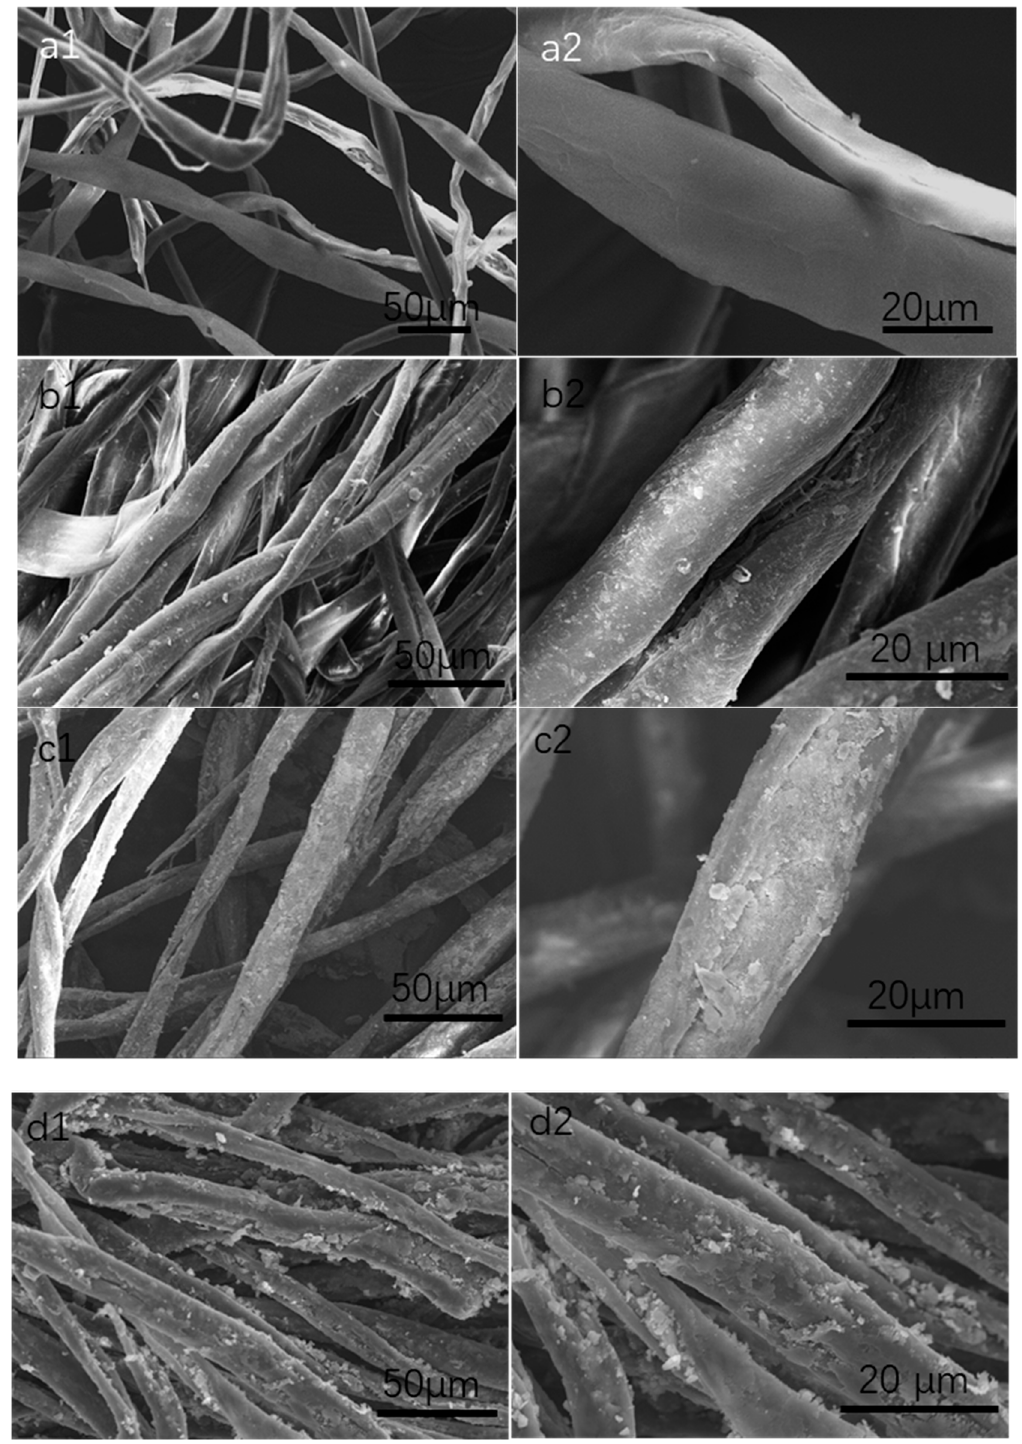
Figure 1. SEM images of raw cotton fabrics ( a1 , a2 ), cotton fabrics modified with different amount of ferric chloride and ferrous chloride ( b1 , b2 ) 0.54 g/0.19 g; ( c1 , c2 ) 0.80 g/0.30 g; ( d1 , d2 ) 1.0 g/0.35 g.